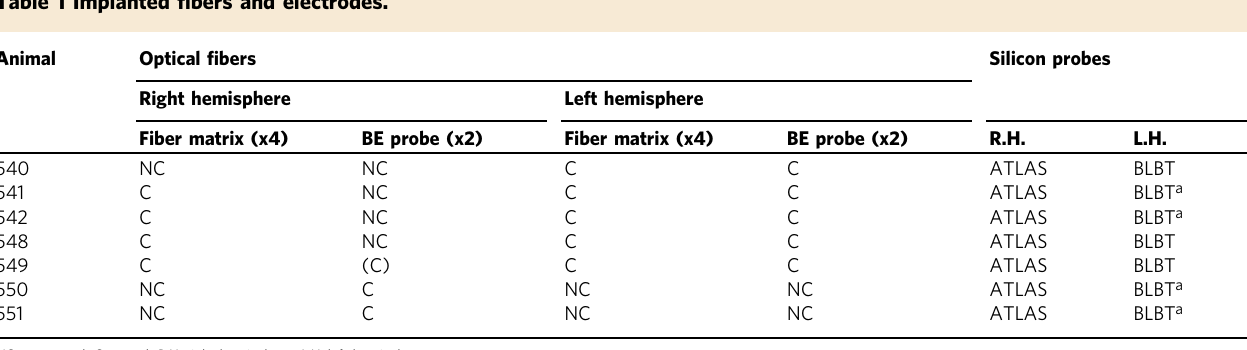
Table 1 Implanted fi bers and electrodes.